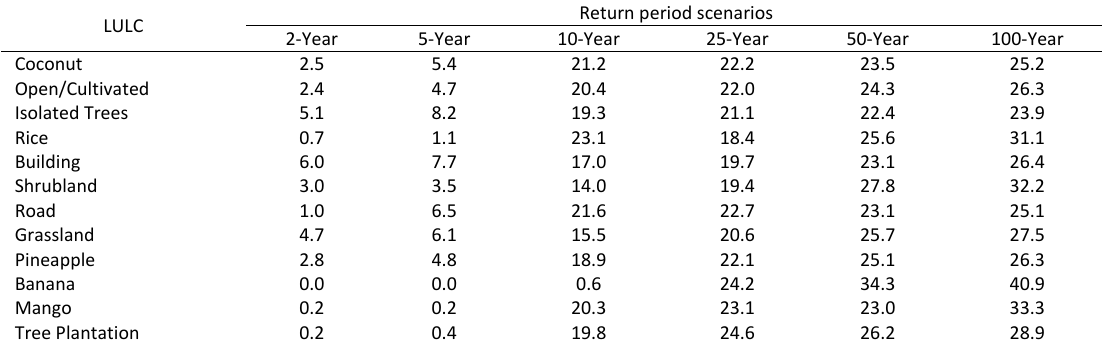
Table 3: Percentage (%) of flood risk exposure by total across return periods LULC Coconut